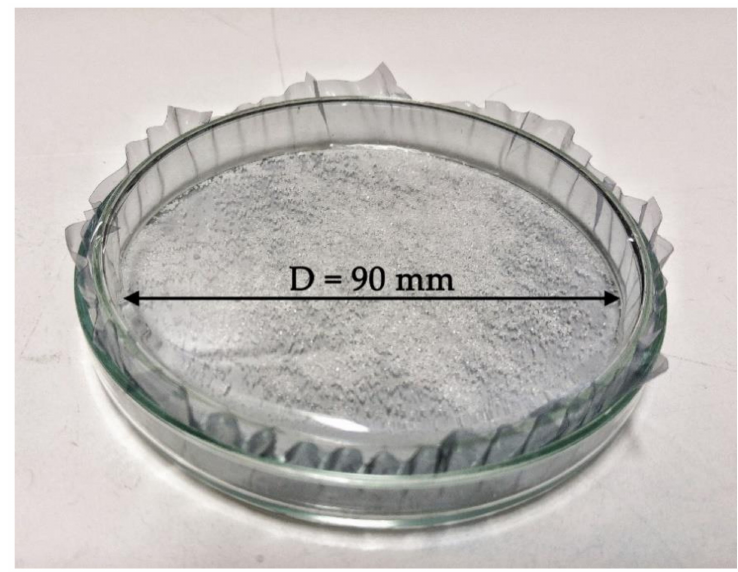
Figure 4. Abrasion cell loaded with a TiN/LDPE-nanocomposite and sodium chloride as abrasive